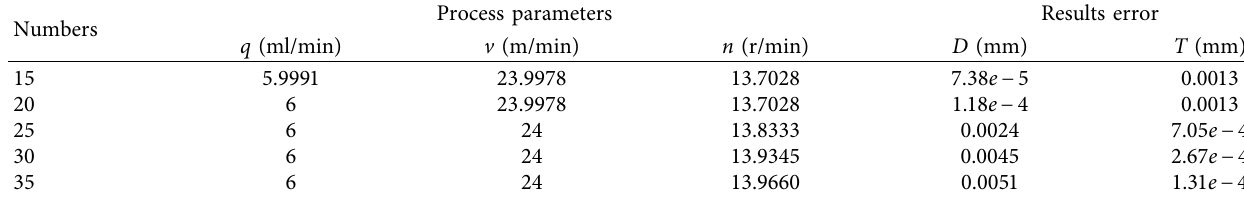
Table 5: Five optimal solutions of target size (1, 0.2).